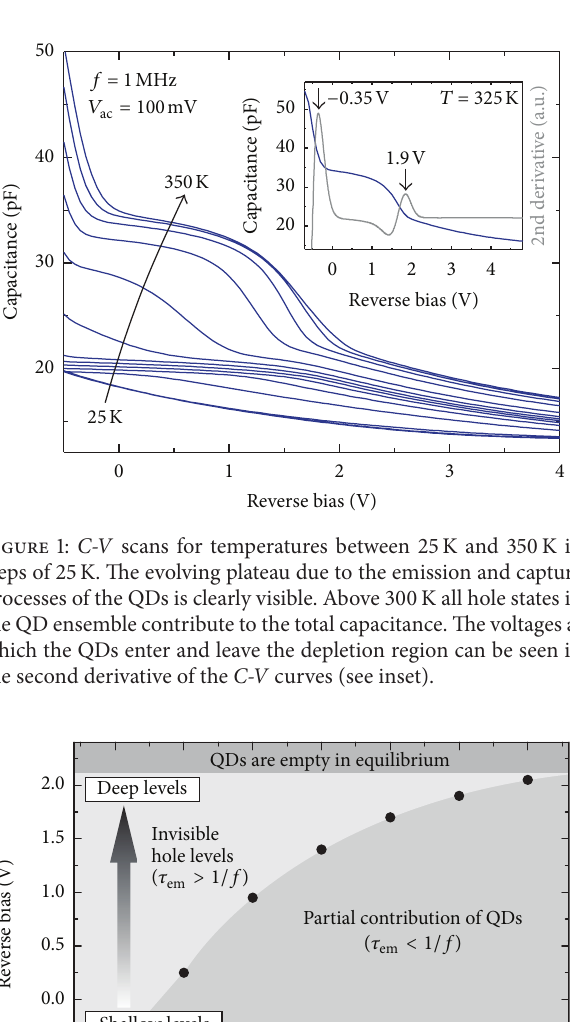
and where they leave the depletion region of the pn diode (see inset of Figure 1). The start and end voltages of the C-V curves with a plateau are shown as a function of temperature in Figure 2. The shaded regions in the graph mark different situations in the diode for a measurement frequency of 1 MHz. Below a reverse bias of about − 0.5 V (i.e., forward direction), the depletion region does not extend to the position of the